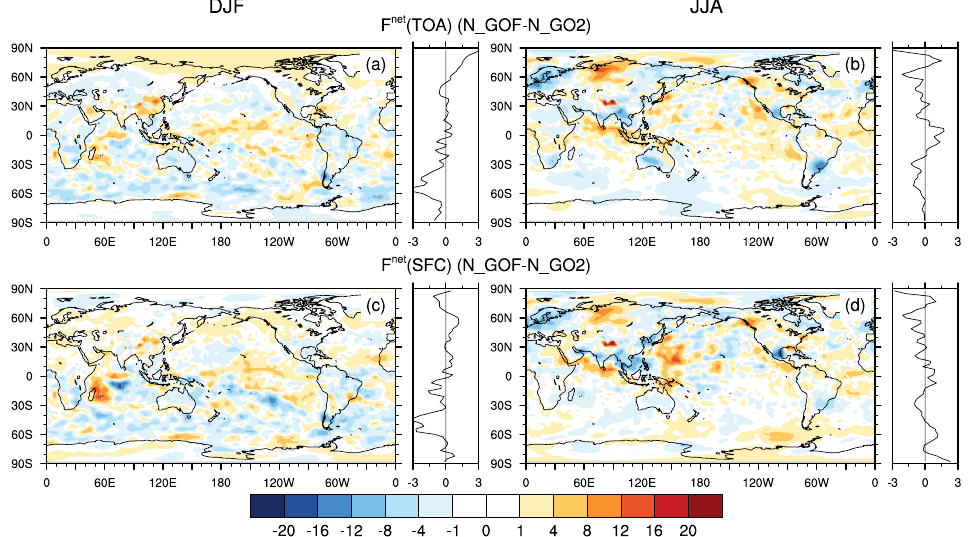
Fig. 10. Differences in net radiative budget (a, b) at the TOA and (c, d) at the surface between N_GOF and N_GO2, for DJF (left) and JJA (right).